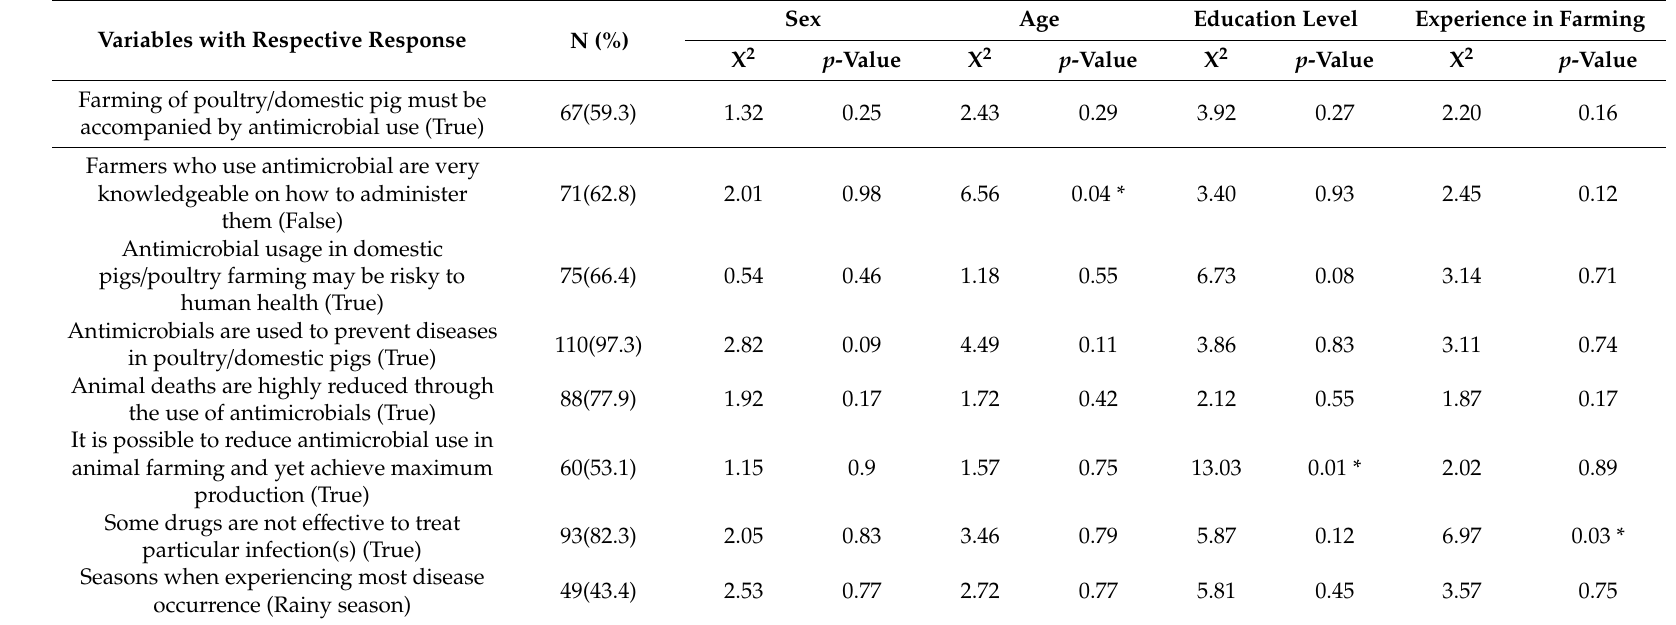
Table 4. Respondent’s perception and attitudes on the use of